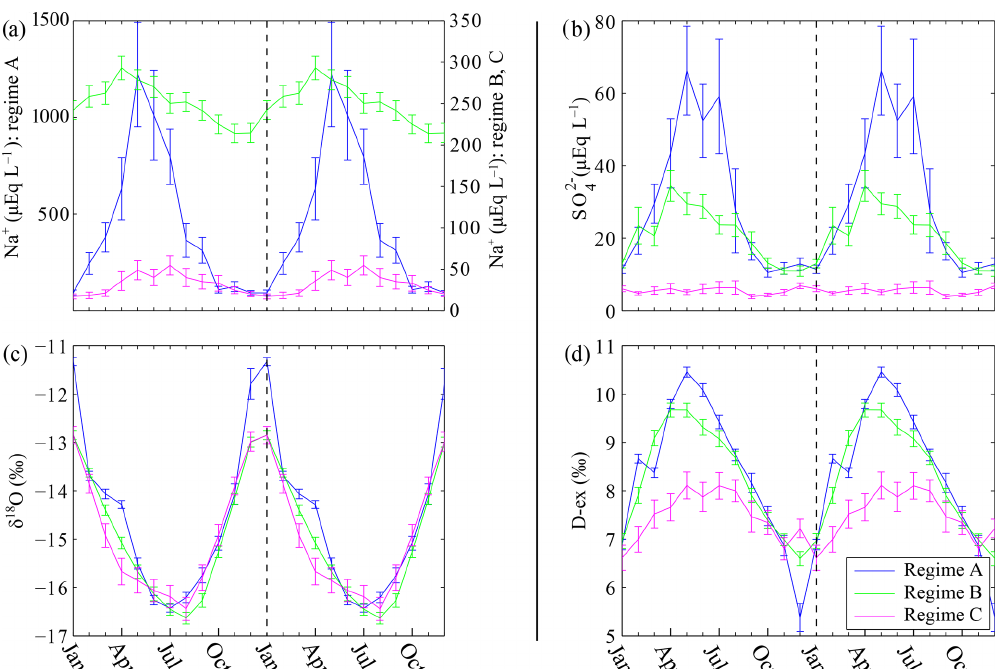
− , (c) δ 18 O, and (d) D-ex for each regime. Regime A: 2001–2009 (blue); regime B: Figure 7. Average seasonal cycles of (a) Na + , (b) SO 2 4 1934–2000 (green); regime C: 1913–1933 (magenta). The x axis shows the month, and the y axis shows the concentration/ratio. Note that the Na + concentration is shown with a different scale for regime A (left y axis) and regimes B and C (right y axis).